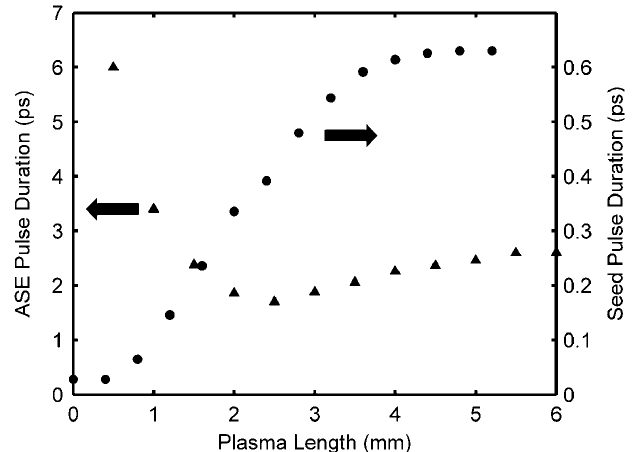
FIG. 5. Computed variation of the FWHM pulse duration of the (cid:1) ¼ 8 : 85 nm ASE laser (triangles), and amplified high- harmonic seed pulse (circles) as a function of the lanthanum plasma column length. The seed-pulse duration initially in- creases due to linewidth narrowing and later, by saturation broadening. The high-harmonic seed pulse is assumed to have an energy of 0.1 nJ and the gain and plasma conditions are those resulting from the simulations described in the